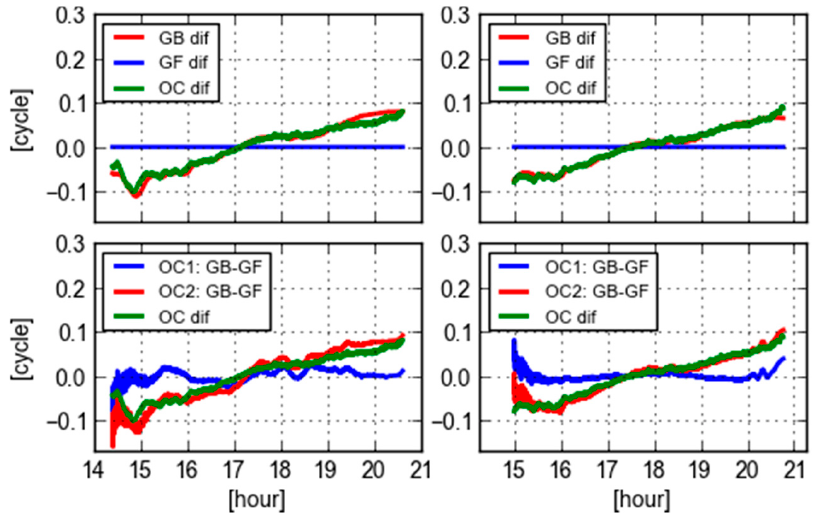
Figure 6. Various differences of PRN 09 WL ambiguities and orbit clock products computed at the receiver CEBR ( left ) and REDU ( right ): (1) differences of GB ambiguities computed with final and real-time orbit clock products are indicated in red in top panels; (2) differences of GF ambiguities computed with final and real-time orbit clock products are indicated in blue in top panels; (3) differences of GB and GF ambiguities computed with final orbit clock products (OC1) are indicated in blue in bottom panels; (4) differences of GB and GF ambiguities computed with real-time orbit clock products (OC2) are indicated in red in bottom panels; (5) differences of orbit clock impacts in LOS directions between final and real-time orbit clock products in green.